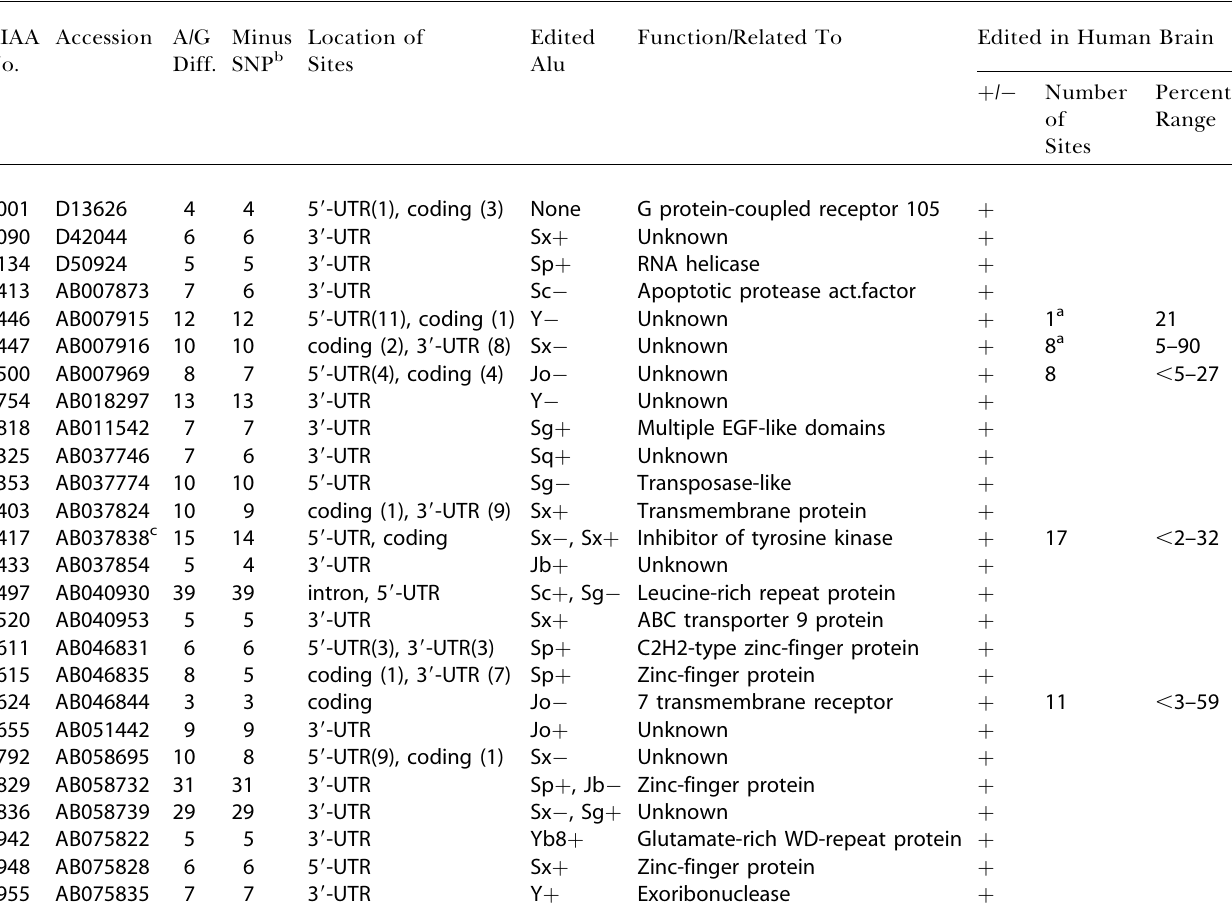
Table 1. A/G Discrepancy Clusters in Human Brain cDNAs KIAA Accession A/G No.